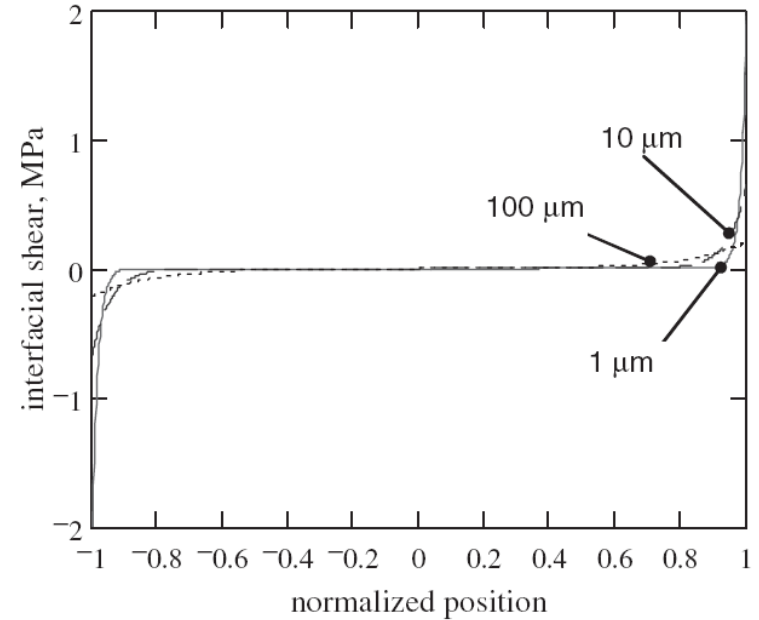
Figure 2. Variation of interfacial shear stress with respect to bond thickness. Taken from